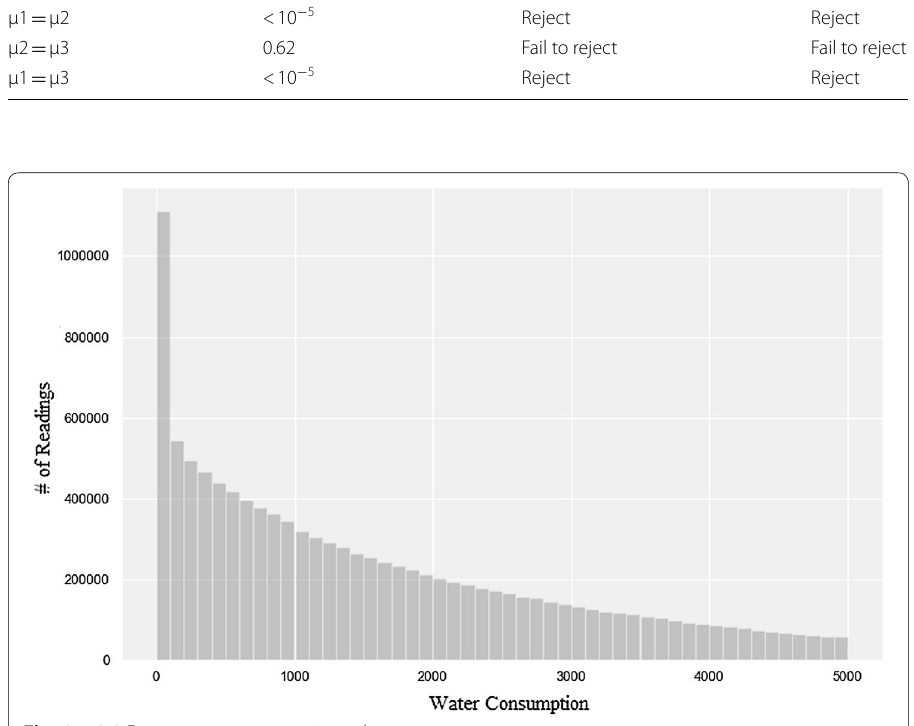
Fig. 6 1-2-2 Factor: water consumption